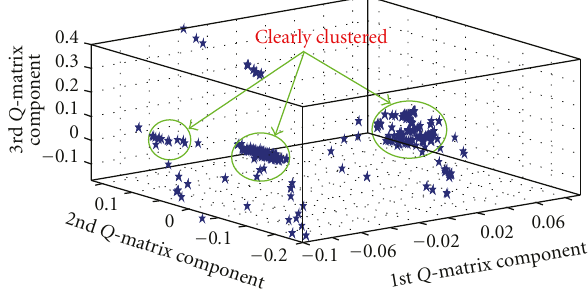
Figure 8: Projection of feature vectors of keyframes frames of four shot-level summaries into the Q -matrix